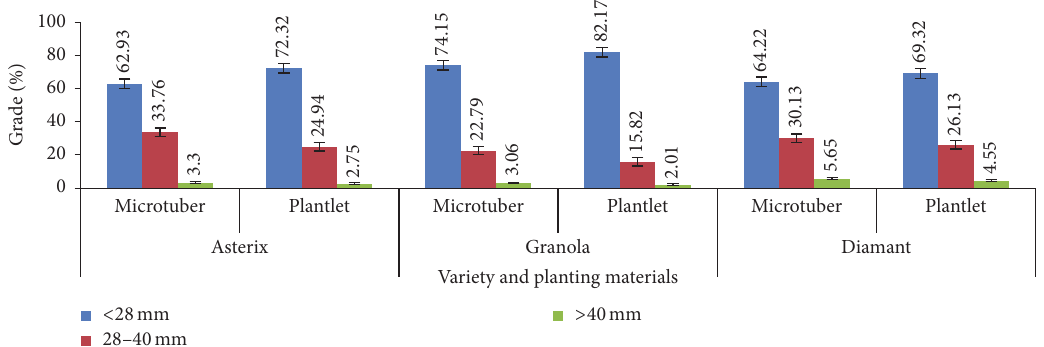
Figure 3: Interaction effects of variety and planting materials of potato on minituber grades according to